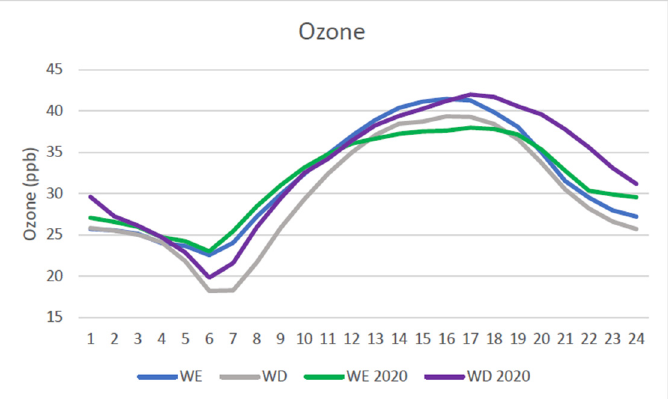
Figure 9. Ground-level ozone (O 3 ) for the average period April to June 2010–2019 for weekends (WE) and weekdays (WD) and for April to June 2020 (WE 2020, WD 2020) at Toronto East.